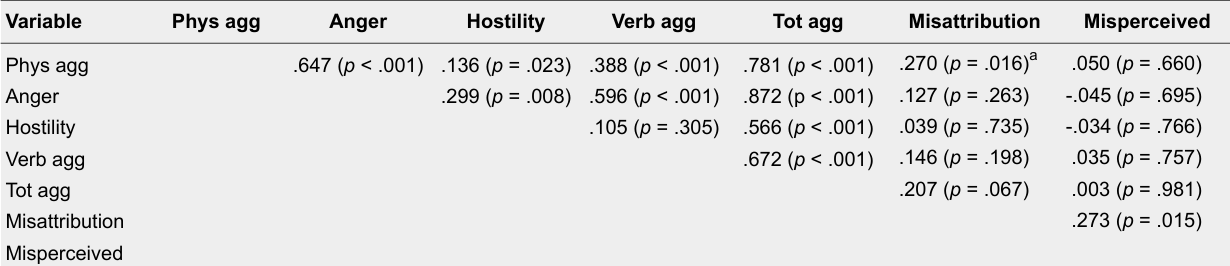
Partial Correlations Among Scores of Verbal Aggression, Anger, Hostility, Physical Aggression, Total Aggression, Misattribution Errors and Misperceived Errors When Controlling for Gender (N = 80)